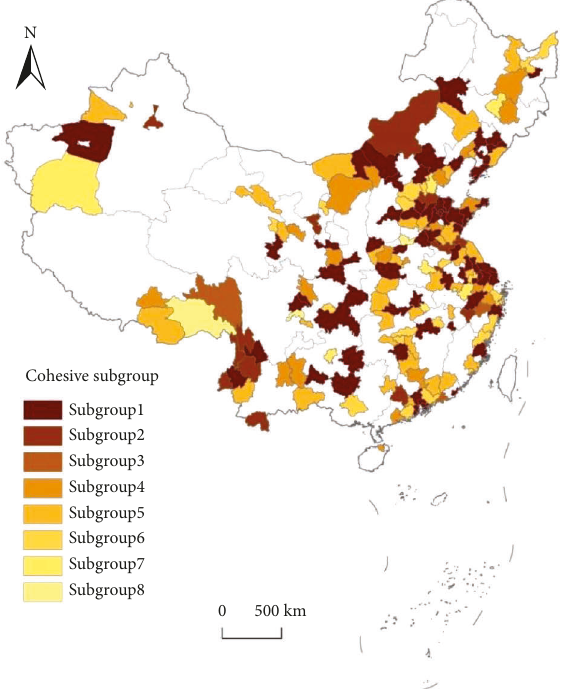
Figure 3: Cohesive subgroups of China’s urban network.